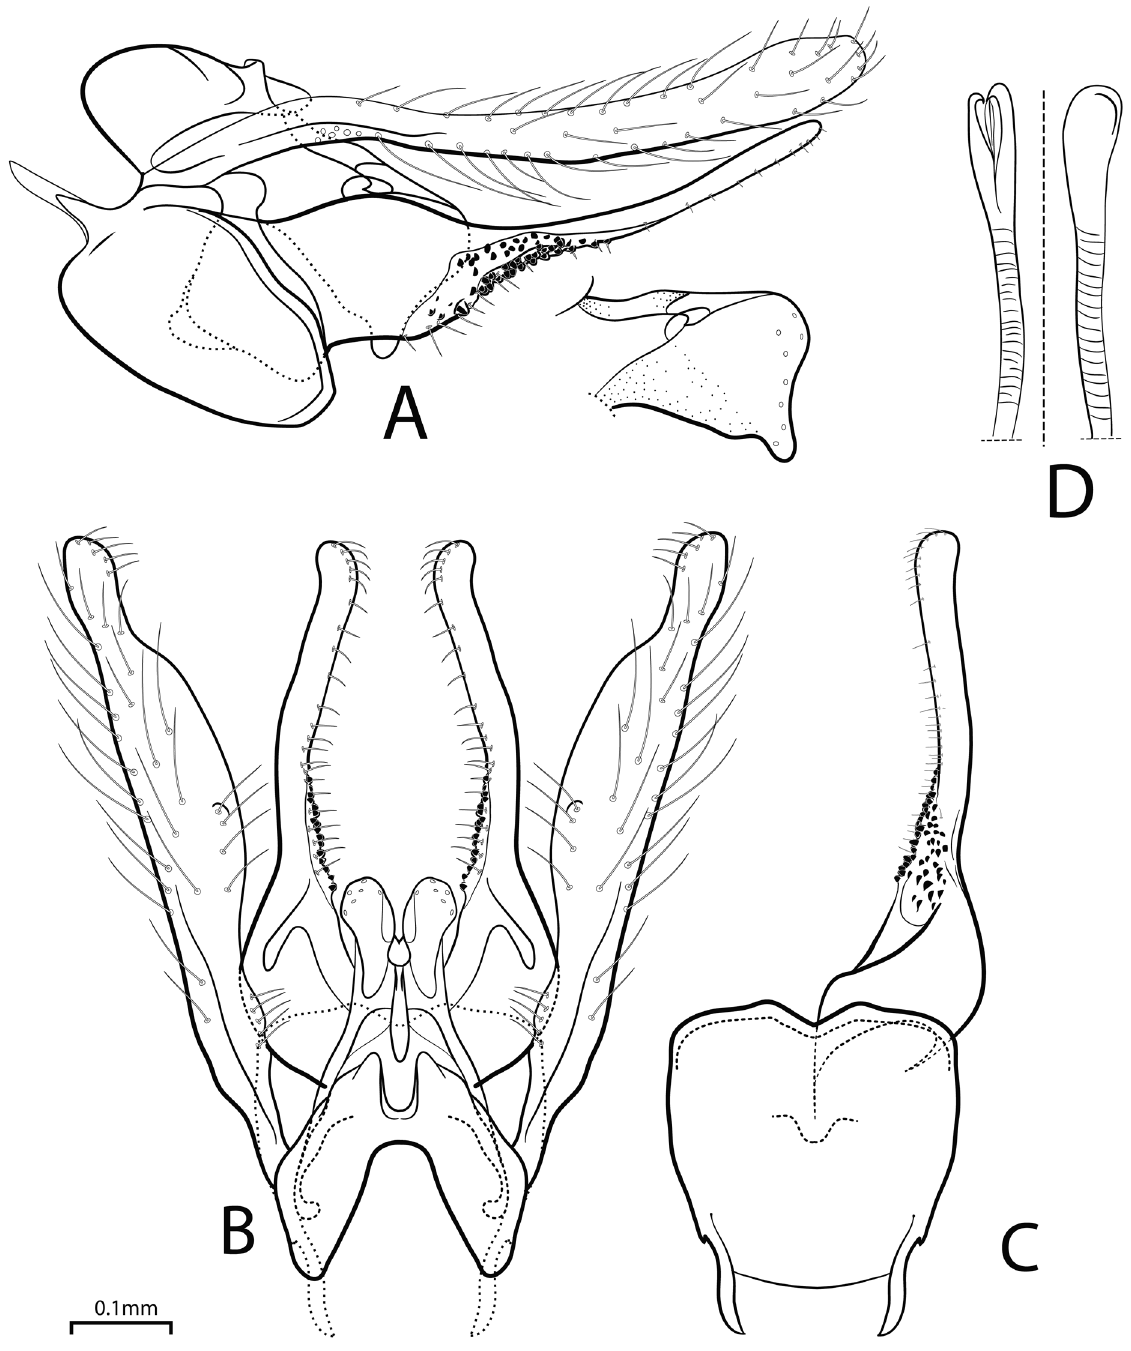
Fig. 5. Xiphocentron ashaninka sp. nov., holotype , male genitalia (MUSM-ENT-0320562). A . Lateral view, with detail of paraproct. B . Dorsal view. C . Ventral view. D . Phallus, dorsal and lateral views,